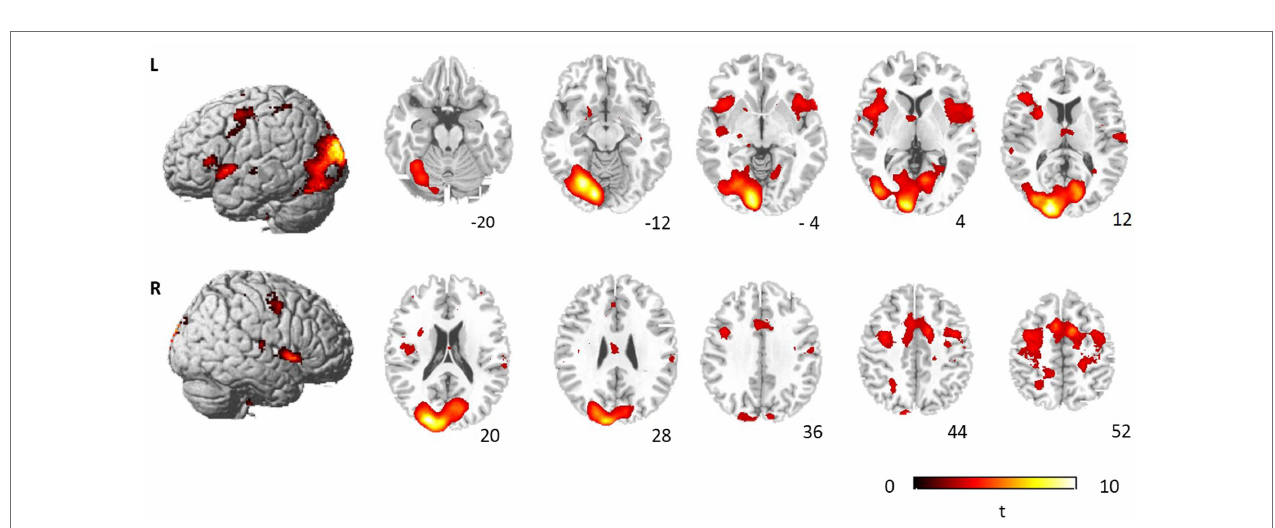
FIGURE 2 | Correlations between L2 reading scores and Accuracy/Reaction time during incongruent judgment.